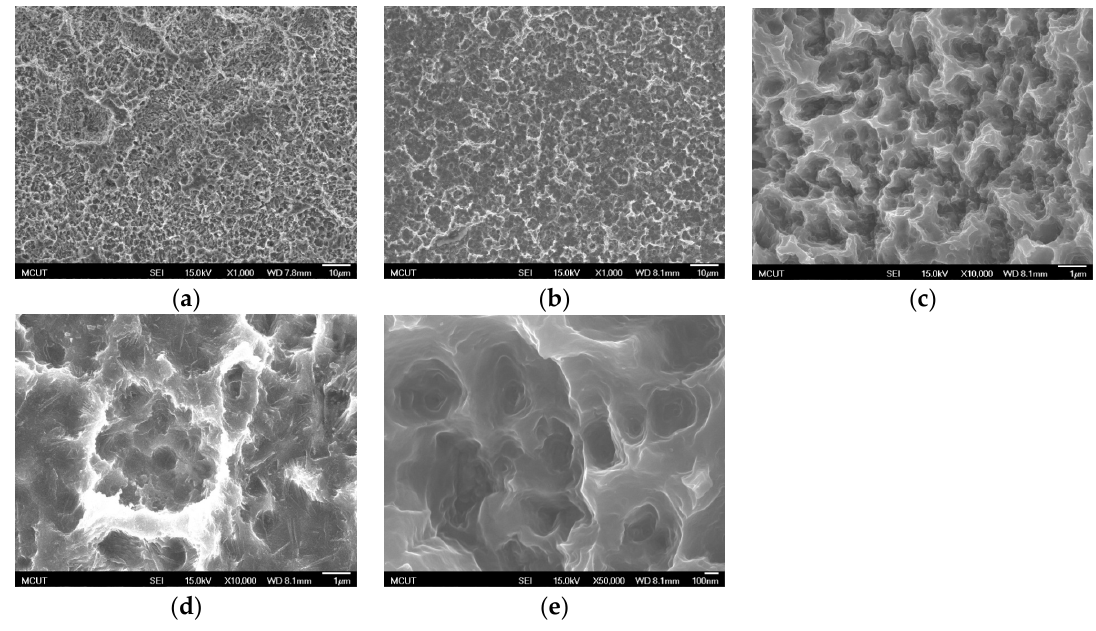
Figure 8. SEM images of Ti-6Al-4V surface after dual acid etching at RT and at BT (1000× magnification): ( a ) HF/H 2 SO 4 /HCl; ( b ) HF/HCl/H 2 SO 4 ; ( c ) HF/H 2 SO 4 (120 °C)/HCl (80 °C); ( d ) HF/HCl (80 °C)/H 2 SO 4 (120 °C); ( e ) H 2 SO 4 (120 °C)/HCl (80 °C); and ( f ) HCl (80 °C)/H 2 SO 4 (120 °C).